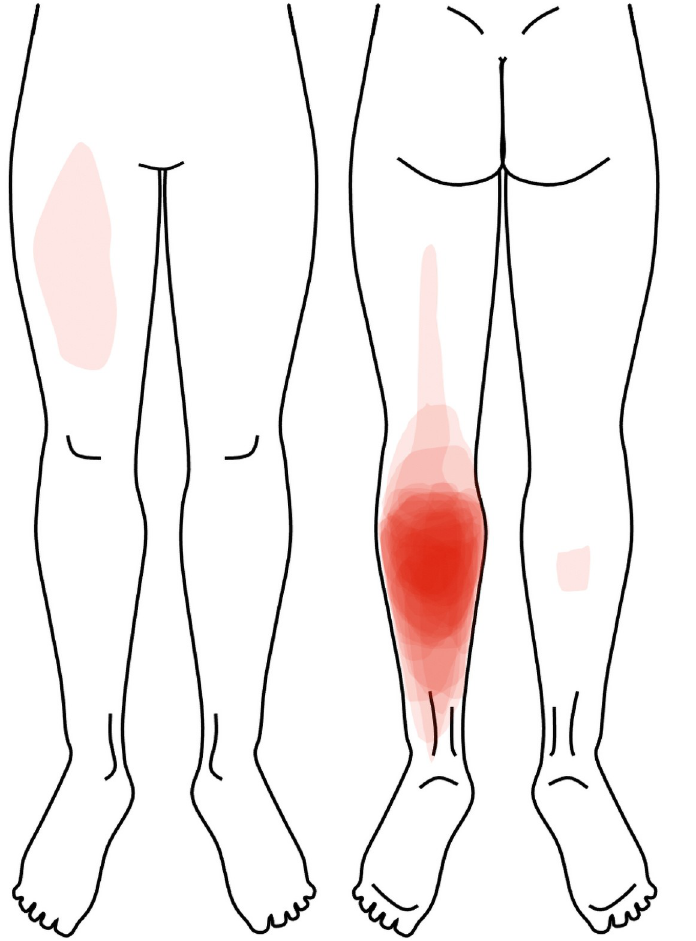
Fig 2. Overlay of all participants location of pain during calf raises on Day-2.